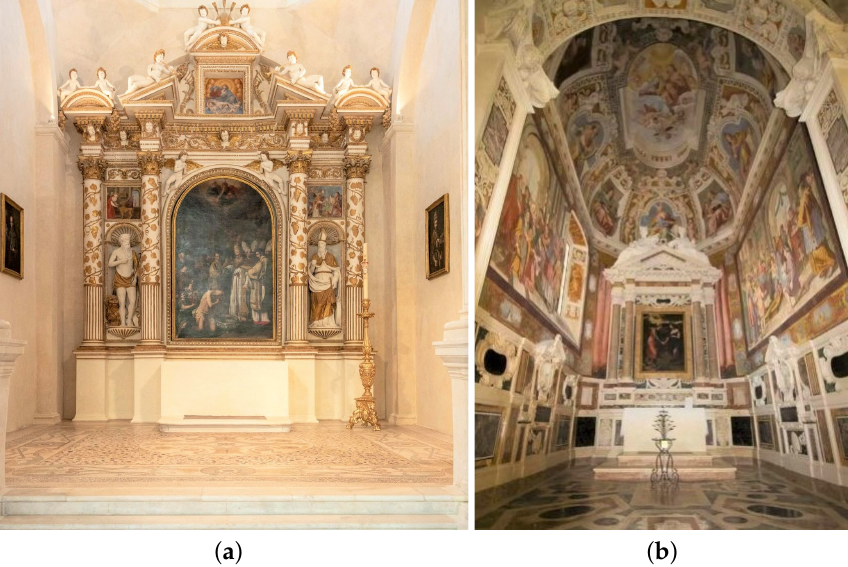
Figure 10. View of the chapel “Cappella degli Stucchi” ( a ); View of the chapel “Cappella Branconio” ( b ).